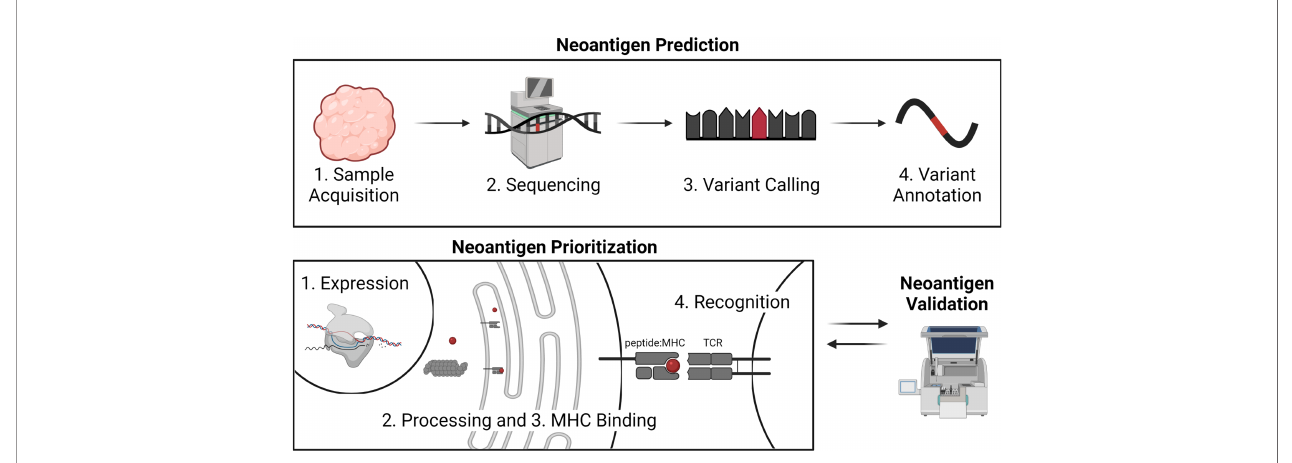
FIGURE 1 | Overview of neoantigen prediction, prioritization, and validation. Neoantigen prediction relies on sample acquisition, high quality sequencing data, variant calling, and variant annotation. Neoantigen prioritization requires predicting some combination of the potential for the neoantigen to be expressed, processed, bound by MHC, and recognized by the T cell receptor (TCR). The development of neoantigen prioritization models relies on the availability of validated datasets of neoantigen immunogenicity. Figure created with